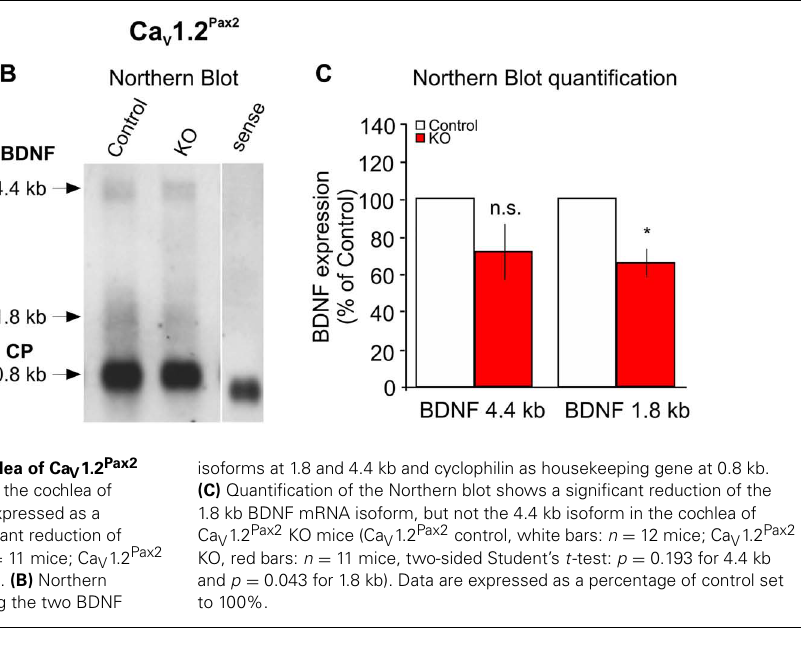
Ca V 1.2 Pax2 KO and Ca V 1.2 Egr2 KO mice do not display